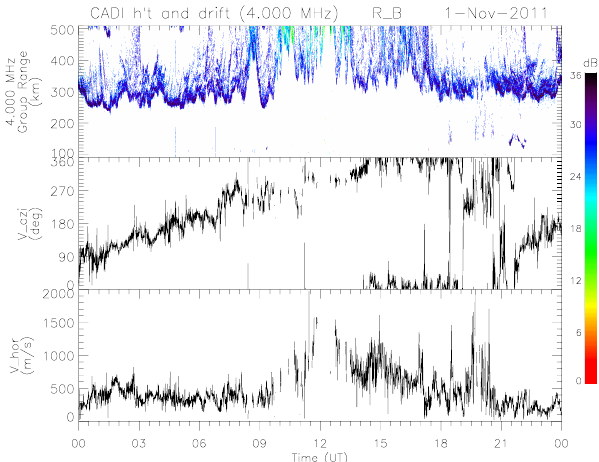
Fig. 4. Fixed frequency ionogram and drift velocity from Resolute Bay on 1 November 2011.